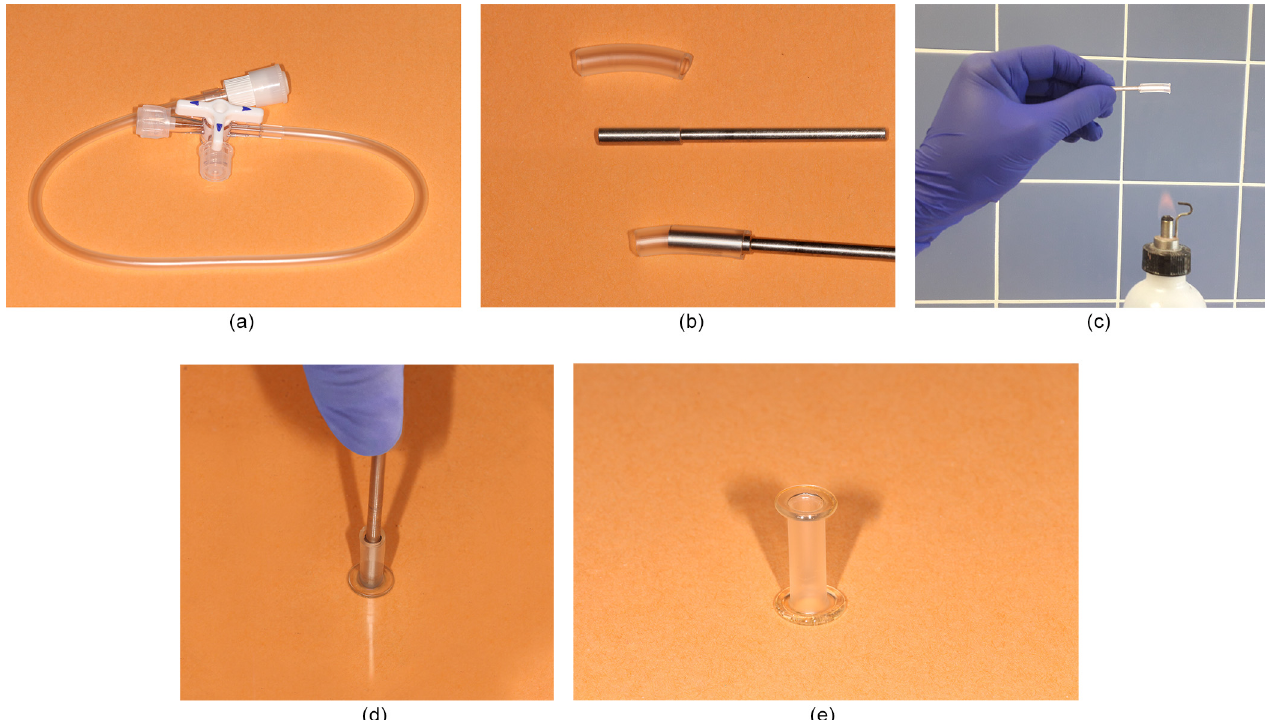
Fig. 6. A method for manufacturing a decompression cannula. The idea is to shape a fl ange at each end of the tube to prevent the cannula from falling outside, or inside the cyst. Depending on the diameter required, any thermoplastic medical plastic tube can be used (intravenous infusion line, nasogastric tube, surgical suction pipe). When the OKC contents is very thick, a wider internal diameter should be chosen to allow the white lumps to be fl ushed out. (a) In this example, a polyvinyl chloride (PVC) intravenous infusion line can easily be cut to the appropriate dimension. (b) A metal mandrel is inserted in the tube, to handle it and maintain its shape while soft. The use of a mandrel represents an improvement of the technique initially described by a Danish author (Dr A Nielsen) in 1988 [40]. The mandrel diameter should be the same as the internal diameter of the infusion line. (c) The end of the tube is held above a fl ame, while rotating the mandrel to distribute the heat. (d) When soft, the tube tip is pressed against a glass plate until it cools. (e) The same process is repeated on the other end to get a double fl anged tube. Before surgery, the tube is soaked in peracetic acid and thoroughly rinsed with distilled